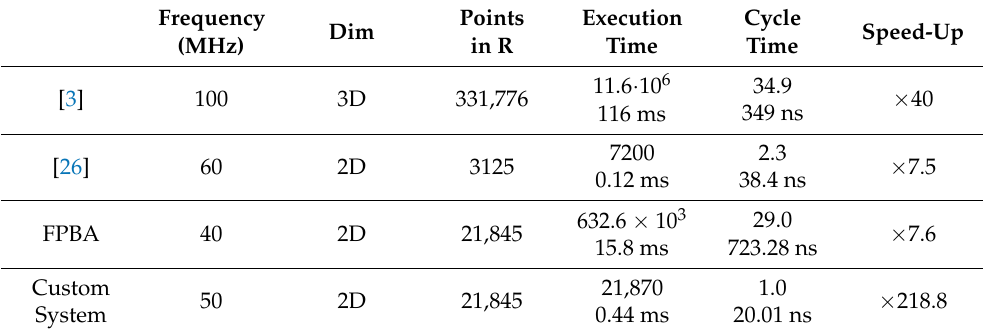
Table 3. Comparison of the DTW algorithms, execution and cycle time (in clock cycles and millisec- onds/nanoseconds), and